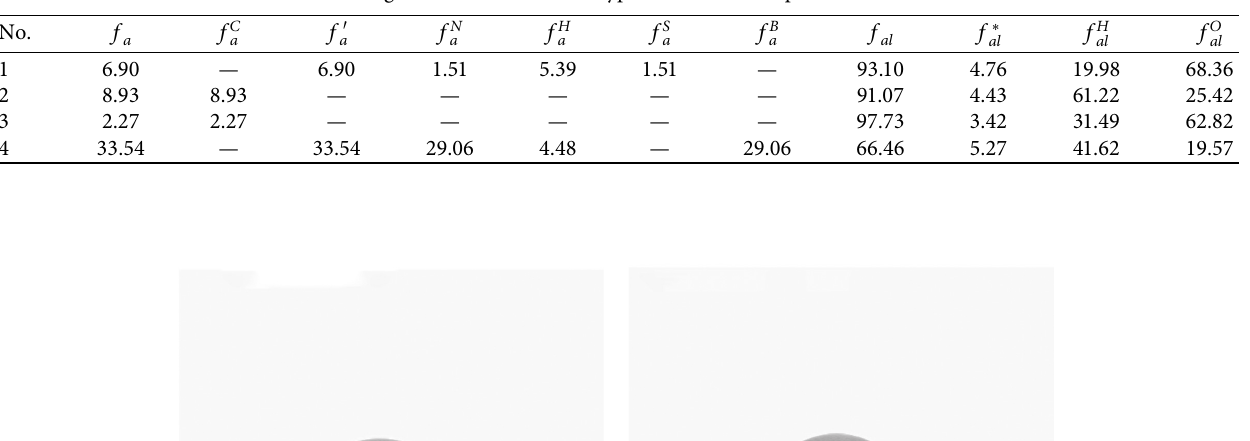
Table 5: Percentages of different carbon types in 13 C-NMR spectra of the surfactants.